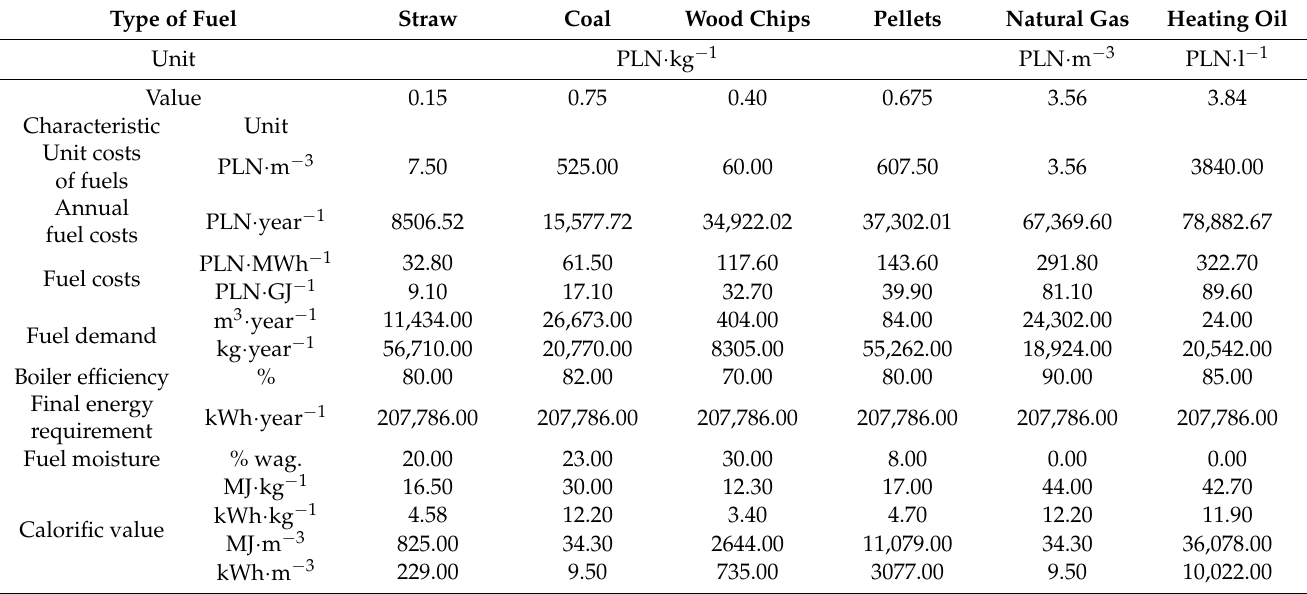
Table 6. Comparison of heating fuels